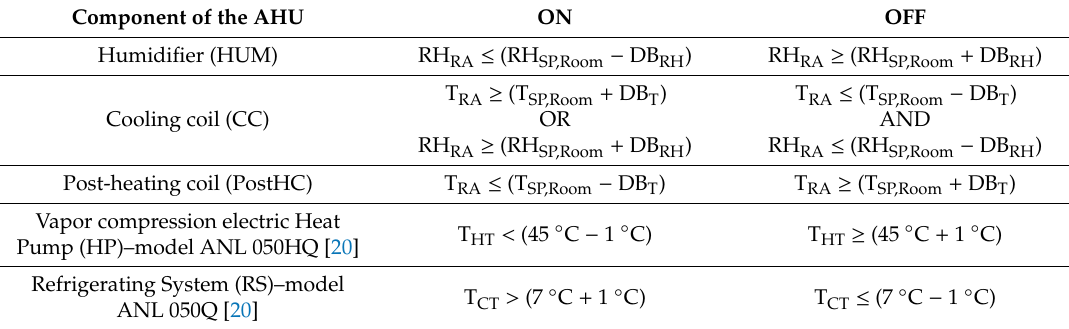
Table 4. Control strategies of the